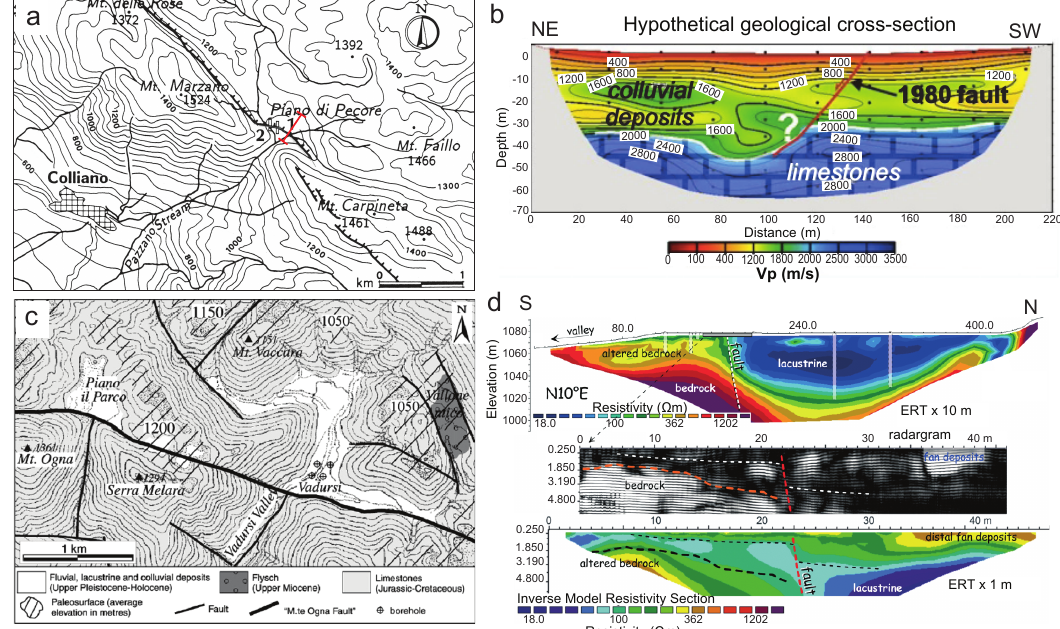
Figure 4. ( a ) Location of the Piano di Pecore basin, created by fault damming of the Pazzano stream with an indication of the coseismic N-facing fault scarp (from Pantosti et al. [13]). ( b ) Seismic tomography and inferred geological cross-section across the Piano di Pecore basin, along the red trace in diagram a, showing thickening of the basin fill toward the southern basin border (from Ascione et al. [78], modified). ( c ) Geological sketch map of the Mt. Ogna area, with the Piano il Parco and Vadursi basins, created by damming of S-flowing stream valleys (from Ascione et al. [78], modified). ( d ) Geophysical investigations of the Piano il Parco basin, showing thickening of the basin fill toward the southern basin border (from Galli et al. [83],